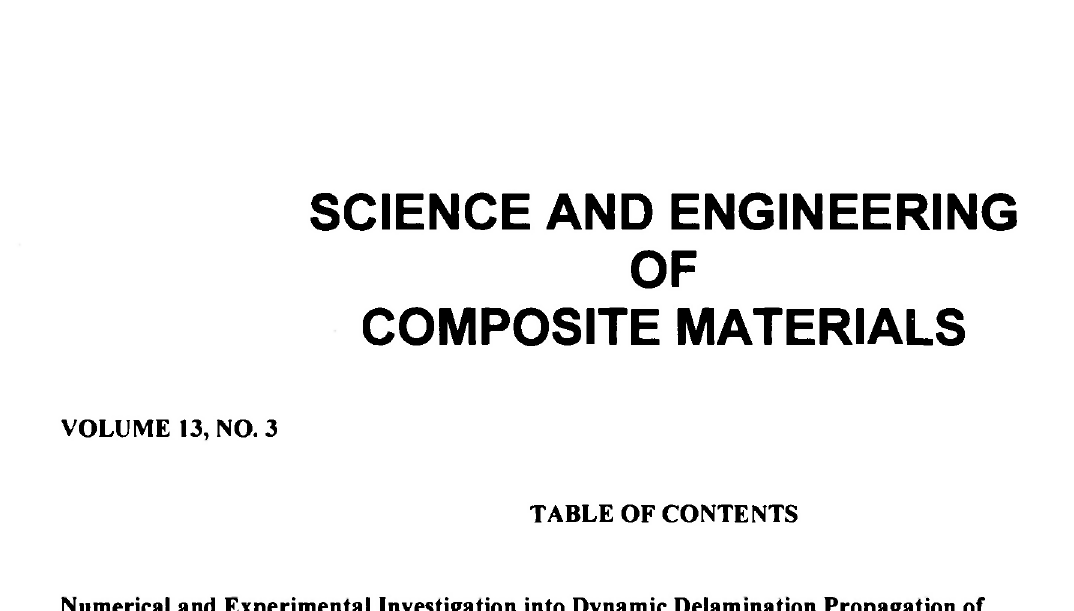
Numerical and Experimental Investigation into Dynamic Delamination Propagation of Axially Impacted Laminated Composite Beams